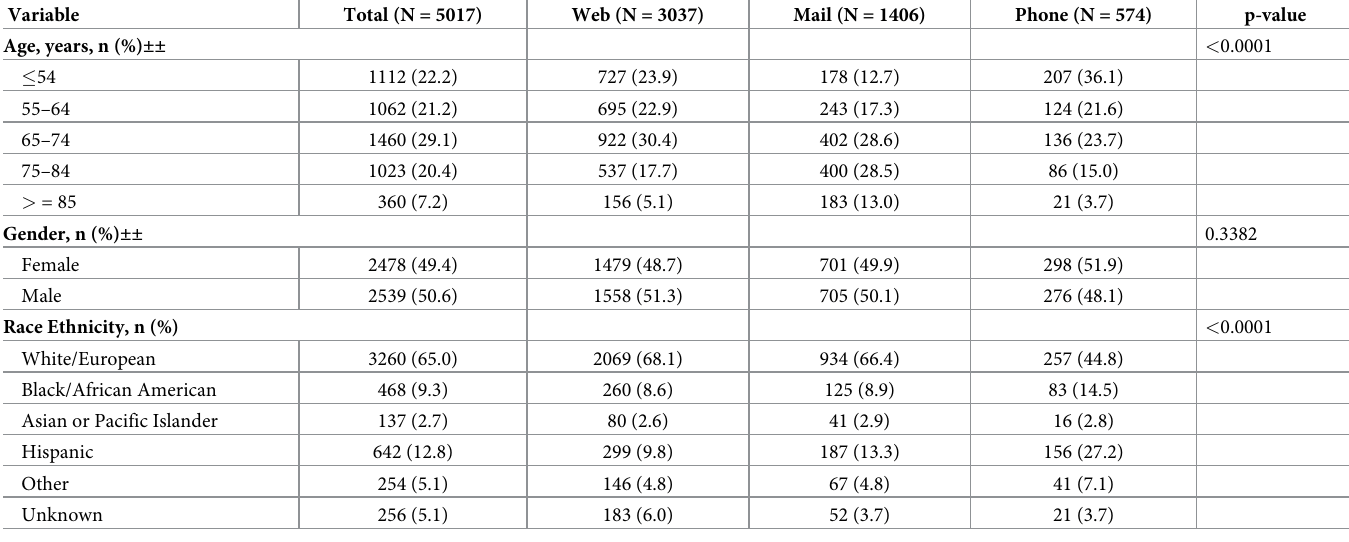
Table 3. Survey completion by survey mode and self-reported race/ethnicity.